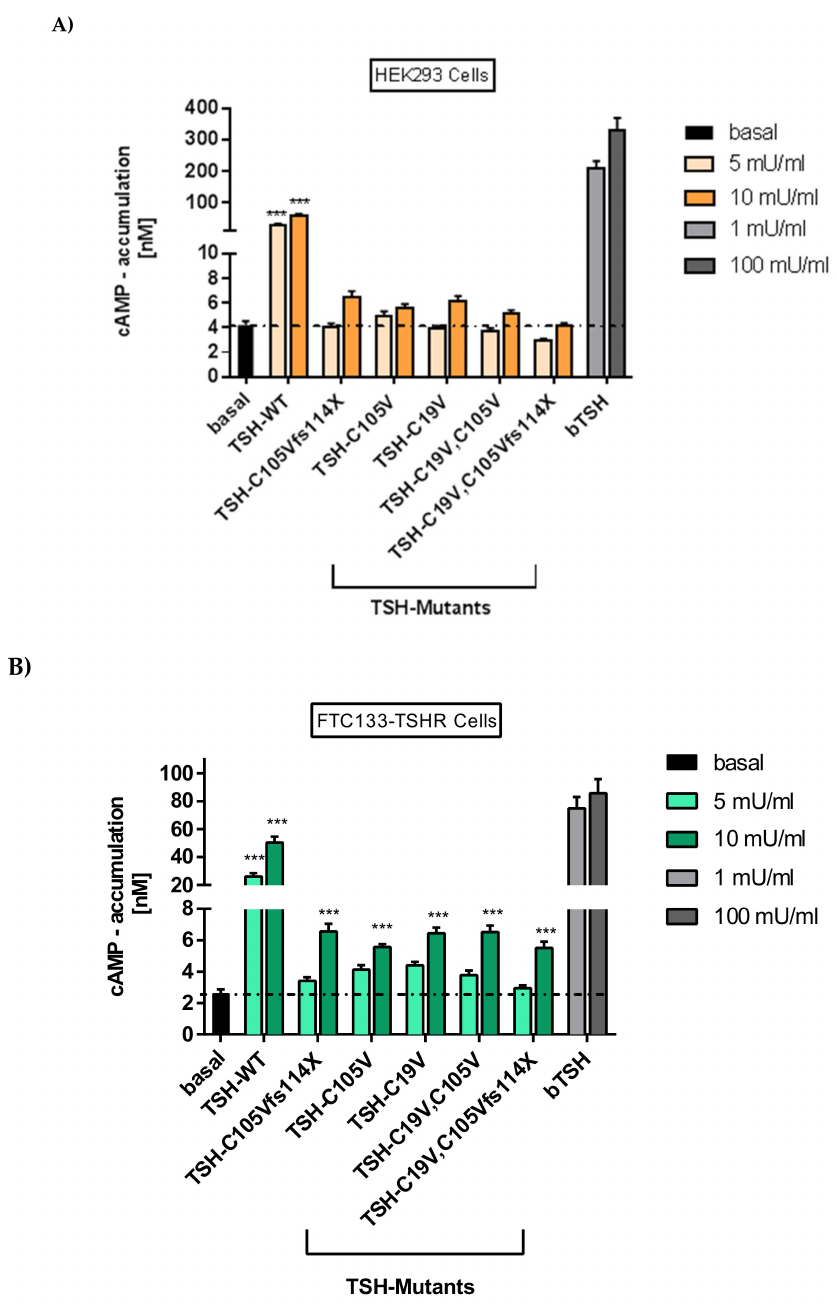
Figure 5. WT-TSH and TSH-variant signaling at TSHR in HEK293 cells and FTC133-TSHR cells. ( A ) Functional characterization of Gs / adenylyl cyclase signaling of WT-TSH and mutants at TSHR in HEK293 cells with di ff erent ligand concentrations. The basal activity of TSHR is shown as black bar / black line. ( B ) Functional characterization of Gs / adenylyl cyclase signaling in FTC133 cells. The basal activity is shown in black / black line. (A,B) bTSH functions as positive control. Data are expressed as mean ± SEM of four independent experiments performed in triplicate. For statistical analysis, one-way ANOVA with the Kruskal-Wallis test was used to test basal activity of the TSHR against the WT and TSH mutants. *** p <